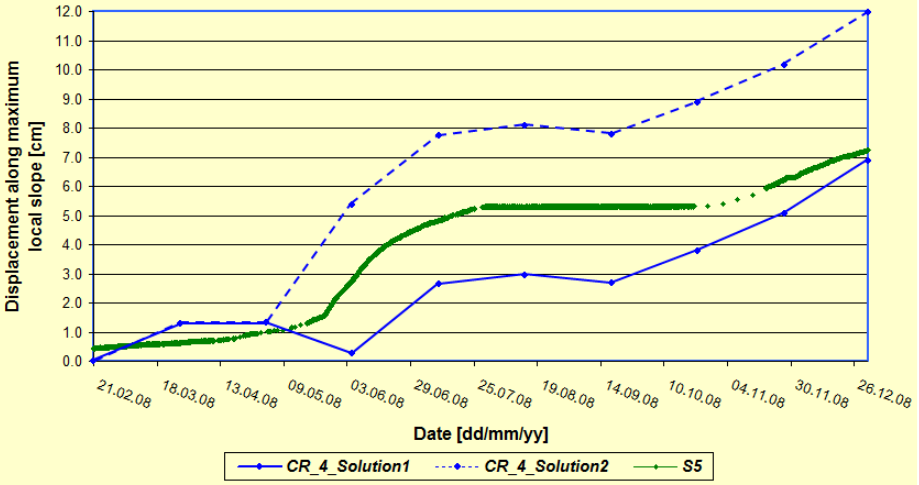
Fig. 7. Displacement time series estimated with DInSAR over one Corner Reflector (CR4), projected in the direction of maximum local slope, and measured by the extensometer S5, located at a distance of 84m from CR4.